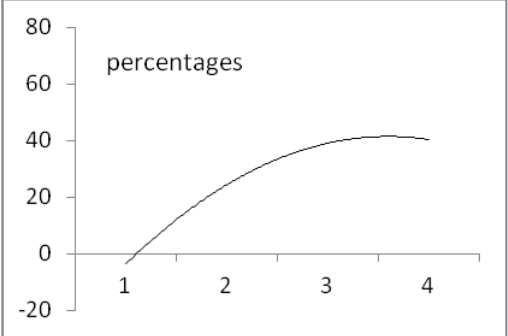
Figure 1. Distribution of